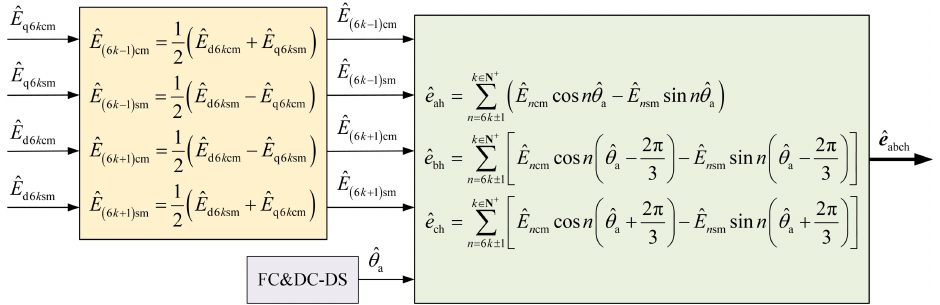
Figure 6. Reconstruction structure of the higher-harmonic voltages.